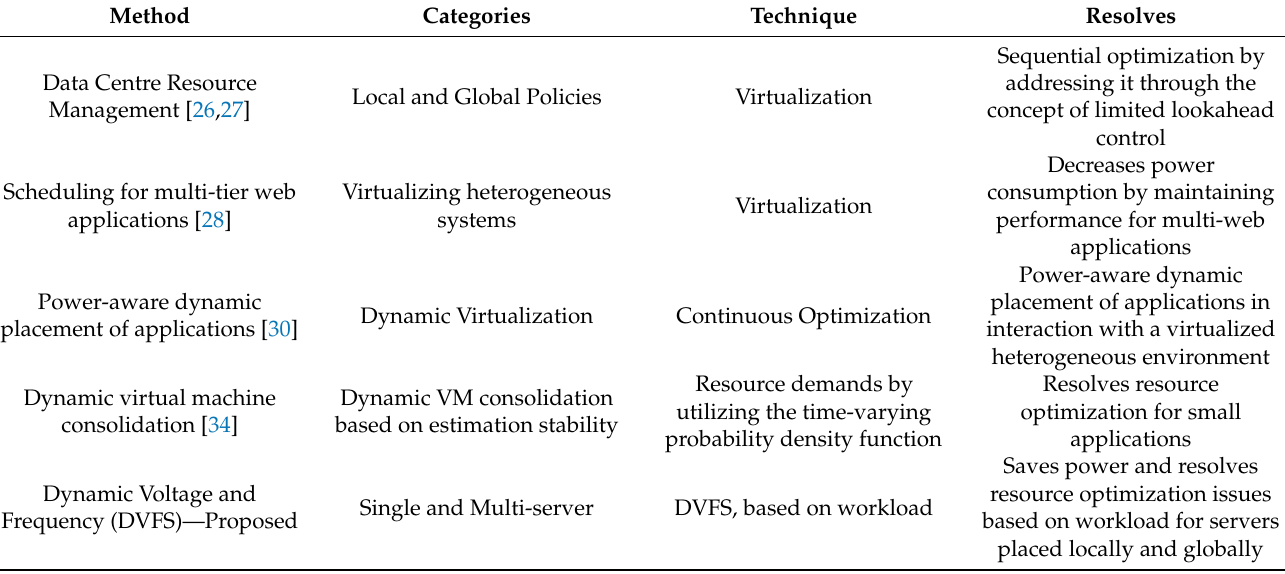
Table 1. Different Optimization